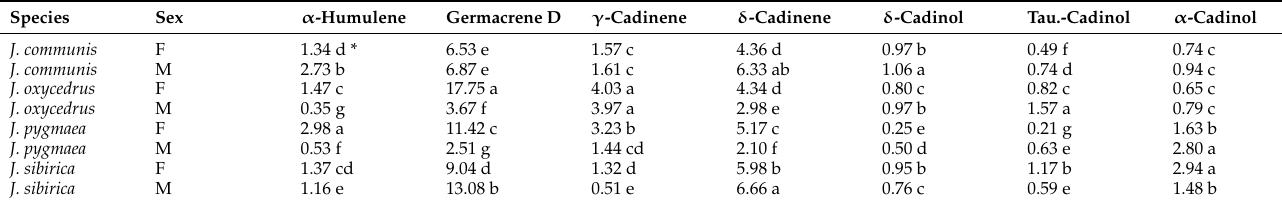
Table 4. Mean concentration (%) of α -humulene, germacrene D, γ -cadinene, δ -cadinene, δ -cadinol, tau-cadinol, and α -cadinol (extracted using the commercial steam extraction method) obtained from the eight combinations of species and